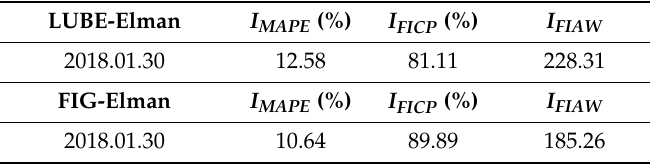
Table 2. Experimental results of two